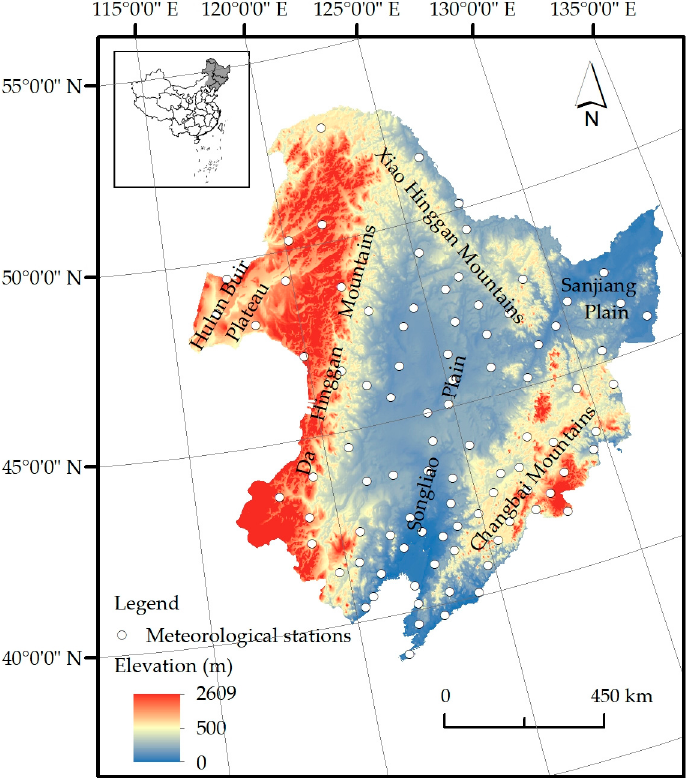
Figure 1. The location of Northeast China and the spatial distribution of the selected meteorological stations.